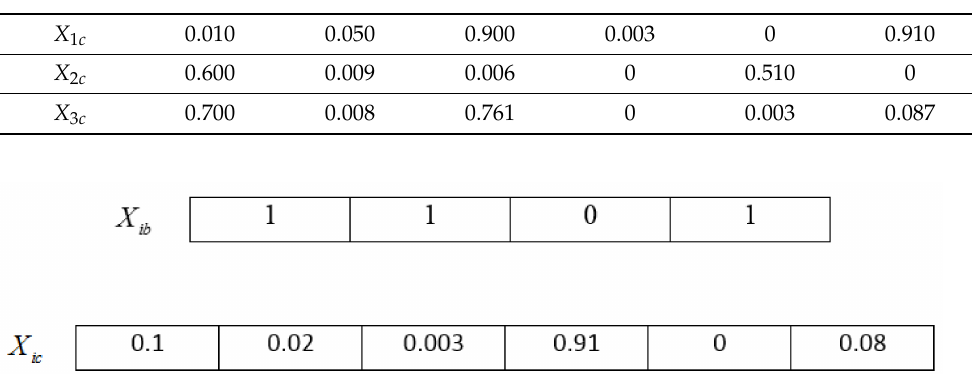
Table 1. An example of a 3 particles continuous swarm with dimension of 6; 2 Primary Users (PUs) and 4 Secondary Users (SUs).